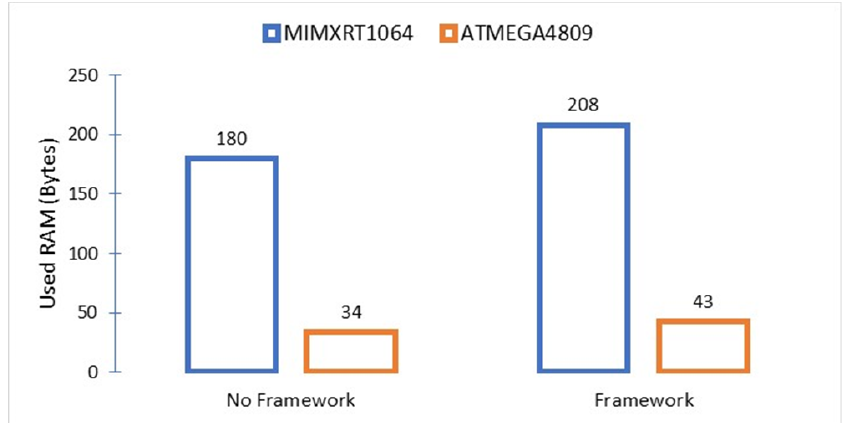
Figure 15. Stack usage comparison for the 32-bit NXP microcontroller (MIMXRT1064) and for the 8-bit Microchip microcontroller (ATMEGA4809) considering the two evaluated